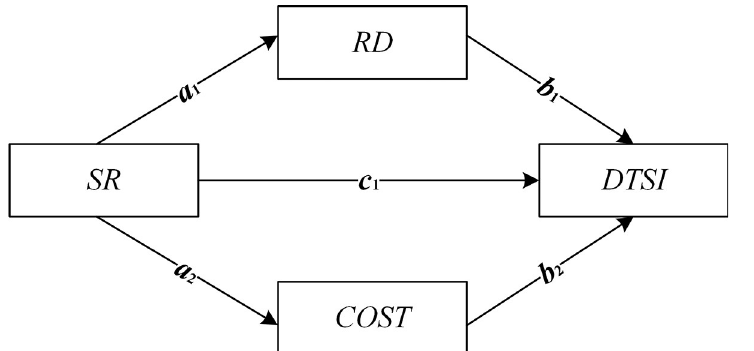
Fig 3. The variable relationships of mediating effects.